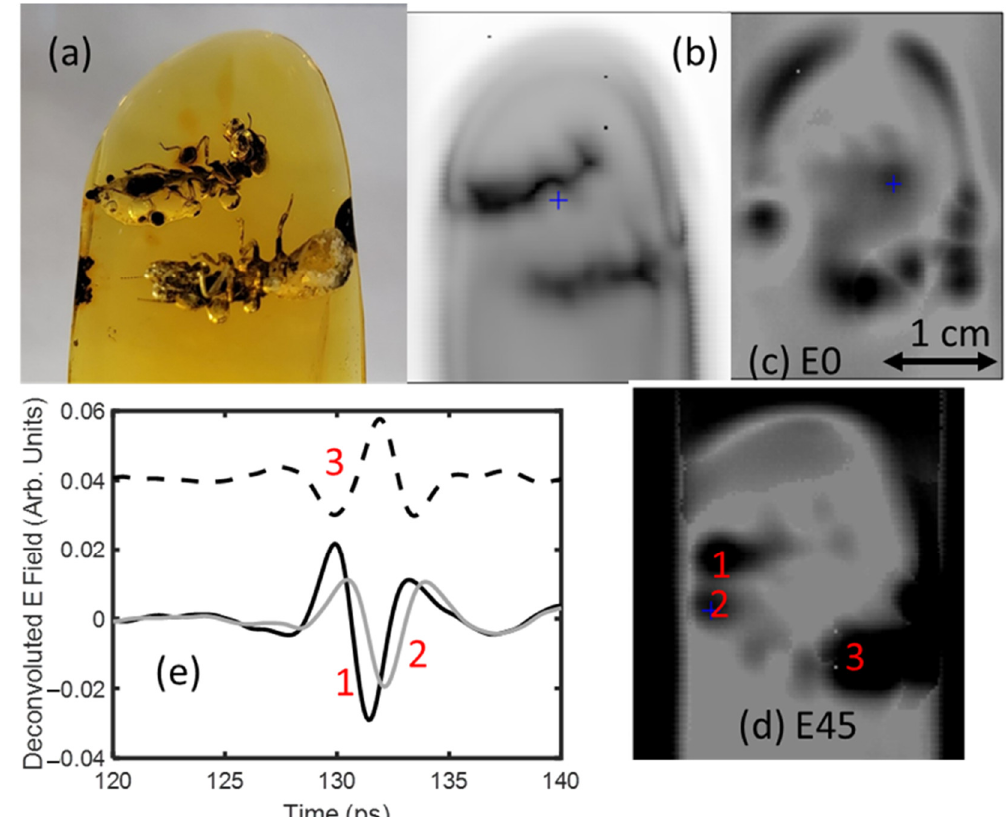
Figure 12. ( a ) Visible image (through mineral oil) of termite inclusions in Dominican amber. ( b ) Logarithm of the transmitted terahertz electric field amplitude in the 0.5–2 THz range. ( c ) Deconvoluted pulse amplitude of E 0 . ( d ) Deconvoluted pulse amplitude of E 45 . ( e ) Deconvoluted pulse shape for positions 1, 2, and 3, as denoted in ( d ).